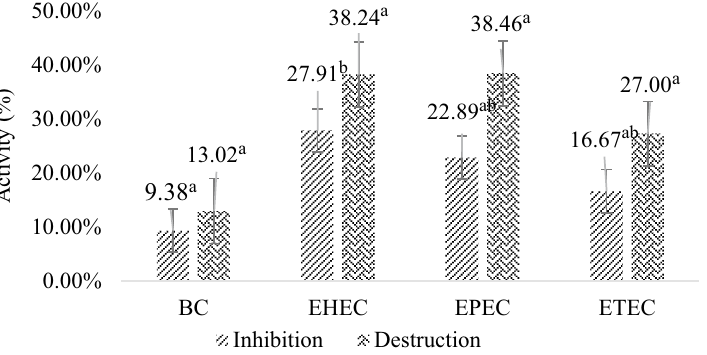
Figure 2. Inhibition and destruction activity of bacteriophage DW-EC against pathogenic bacteria on stainless- steel. Different letters indicate significant different between DW-EC treatment to against several biofilm pathogenic bacteria with P ≤ 0.05.